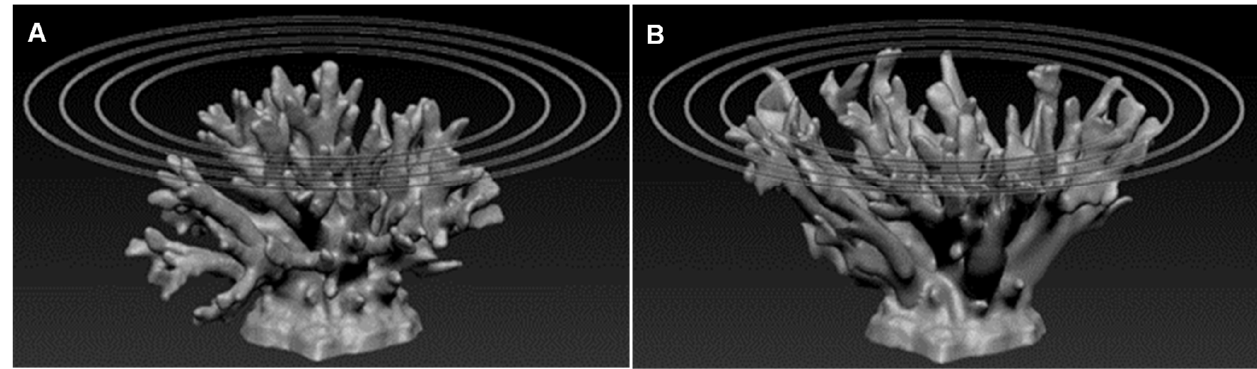
Figure 3. Tabular structure manipulation of the original model ( A ) before and ( B ) after.